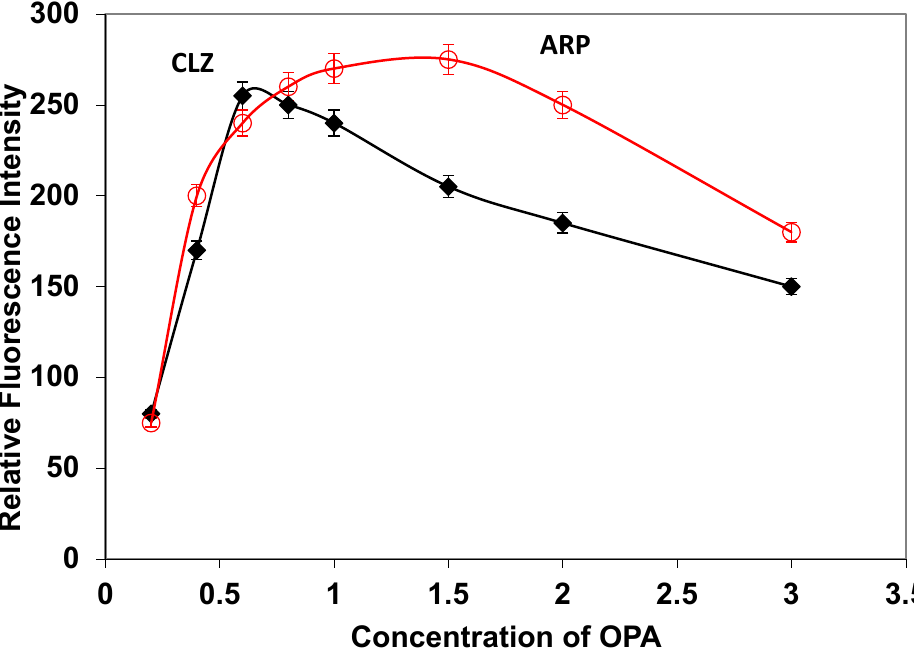
Figure 3. Effect of concentration of o -phthalaldehyde, (0.1% w / v ) on the fluorescence intensity of the reaction product of ARP and CLZ in borate buffer.